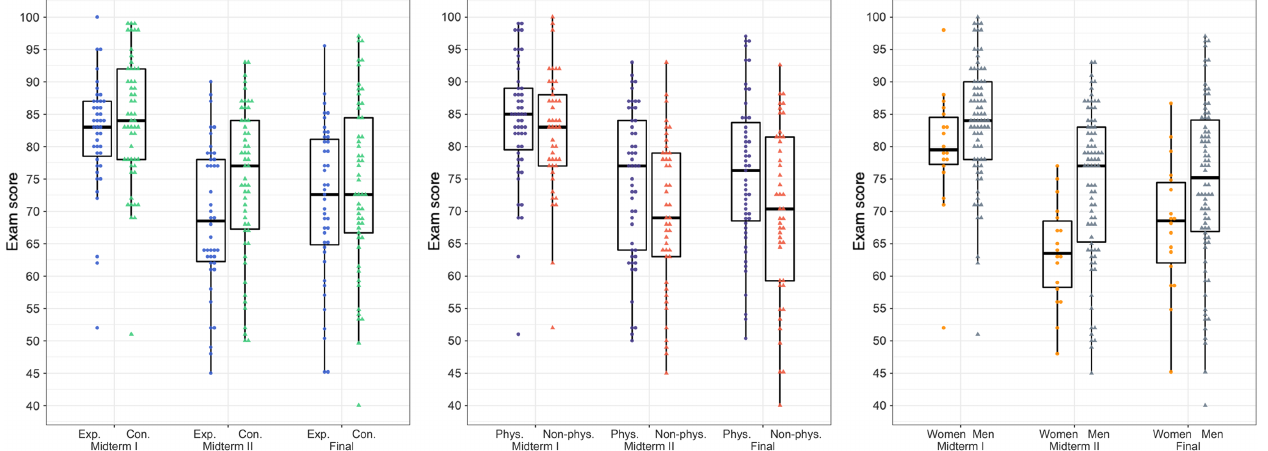
FIG. 2. Pairwise comparisons of exam scores by lab condition (left), major (center), and gender (right) for semester 1 show similar distributions between lab conditions, except on midterm II, but suggest different distributions between physics and nonphysics majors and between women and men on all exams. All exams are scored out of 100.